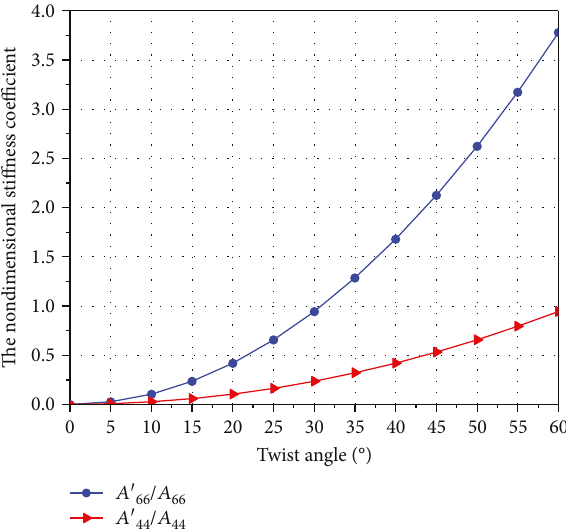
Figure 5: Variations of nondimensional sti ff ness coe ffi cients with the initial twist angle ( η = 0